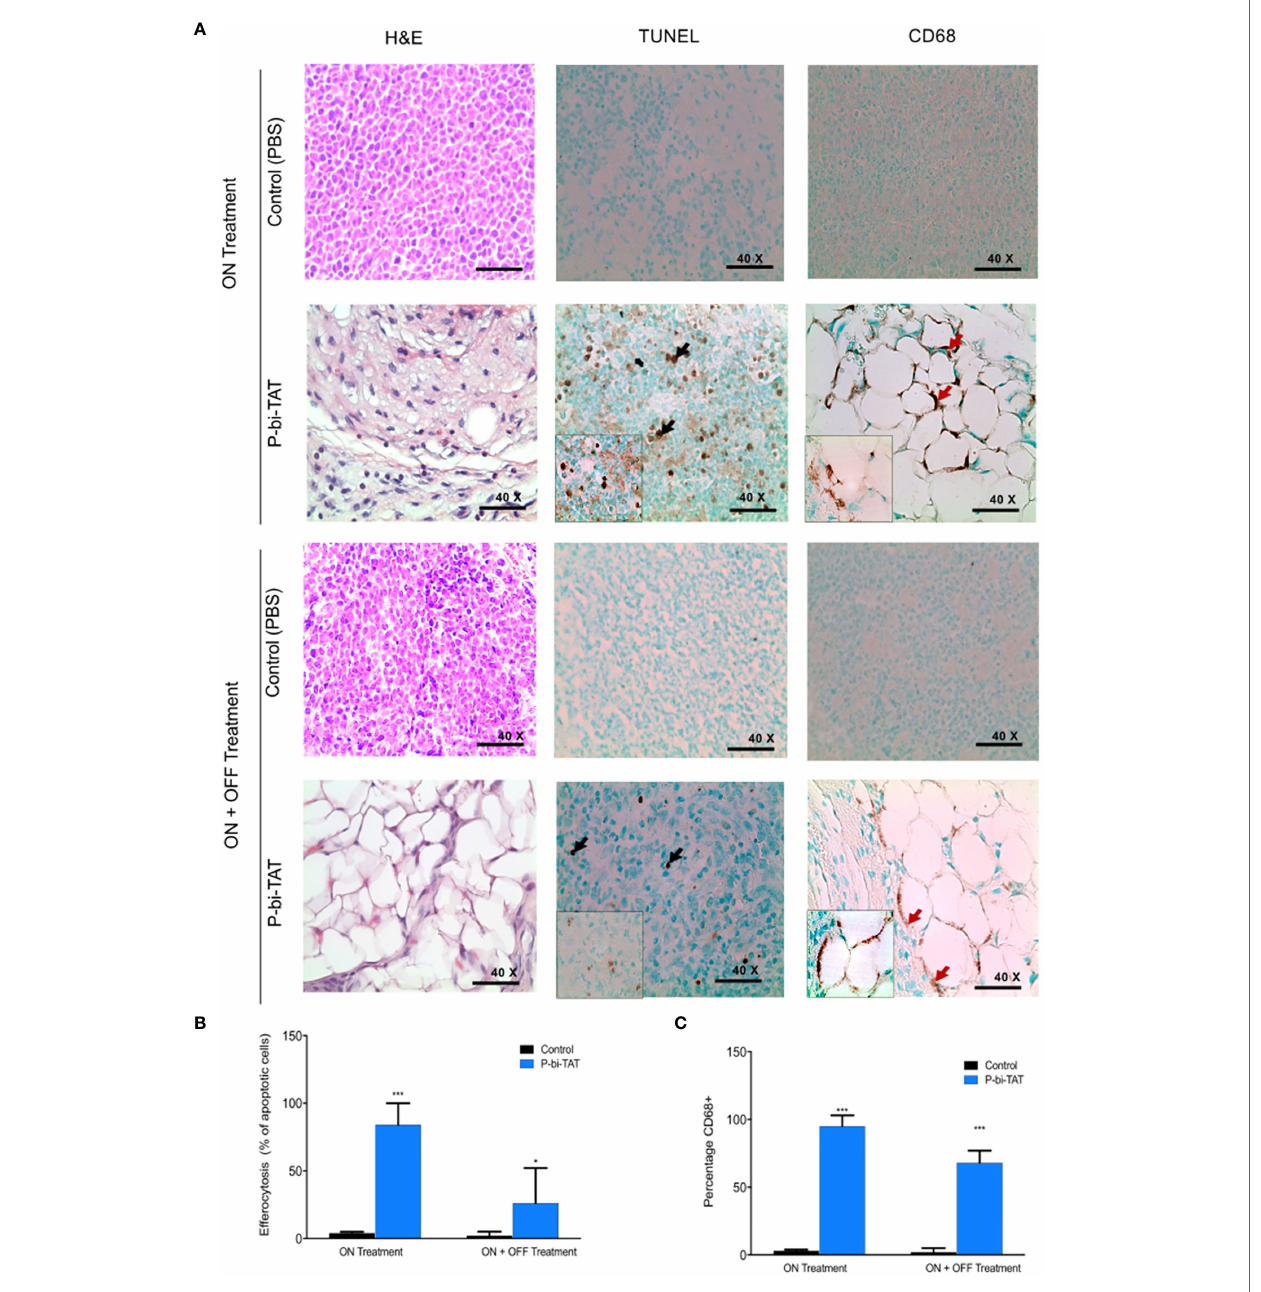
FIGURE 3 | Histopathological evaluation of primary glioblastoma cells (GBM 052814) from tumor tissues excised after treatment of nude mice with P-bi-TAT. Tumor sections were stained for H&E staining, TUNEL assay, and CD68 immunohistochemical staining for each group. Tumor sections were obtained after 21 days of daily subcutaneous injection of PBS and P-bi-TAT (10 mg/kg body weight) (ON treatment) and 21 days after discontinuation of treatment (ON + OFF treatment model). (A) Representative images are presented of H&E staining, TUNEL assay, and CD68 staining. Black arrows indicate apoptotic cells and red arrows indicate macrophages. Scale bar 40 X, insert 100 X. (B) Percentage of apoptosis of tumor tissues in control and P-bi-TAT measured with the TUNEL assay. (C) Percentage of CD68 positive cells per view in control and P-bi-TAT. Values are expressed as percentage of mean ± SD, ***P < 0.0001, *P <